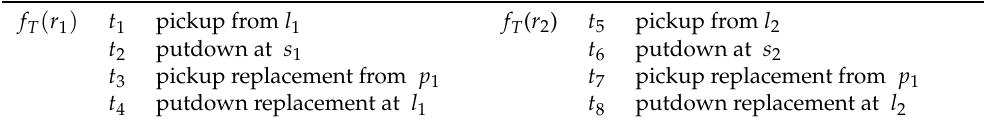
Table 1. Task assignment for robot r 1 and r 2